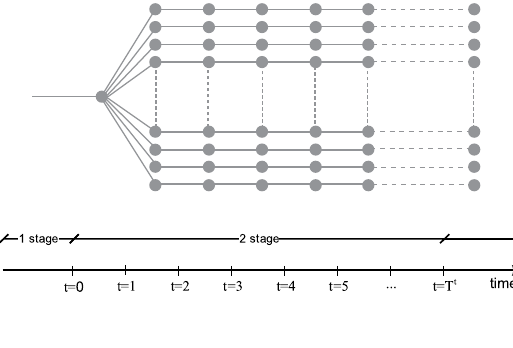
Fig. 5. The illustration of scenarios